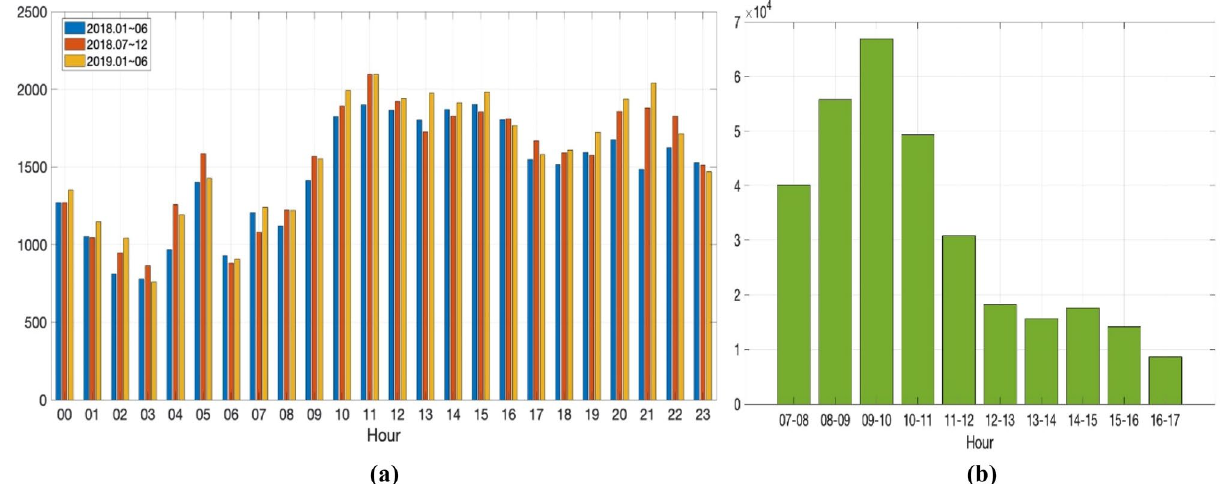
Figure 2. ( a ) Number of ER samples arriving at the department of laboratory medicine by time from January 2018 and to July 2019. ( b ) Number of outpatient samples at the St. Vincent’s hospital in